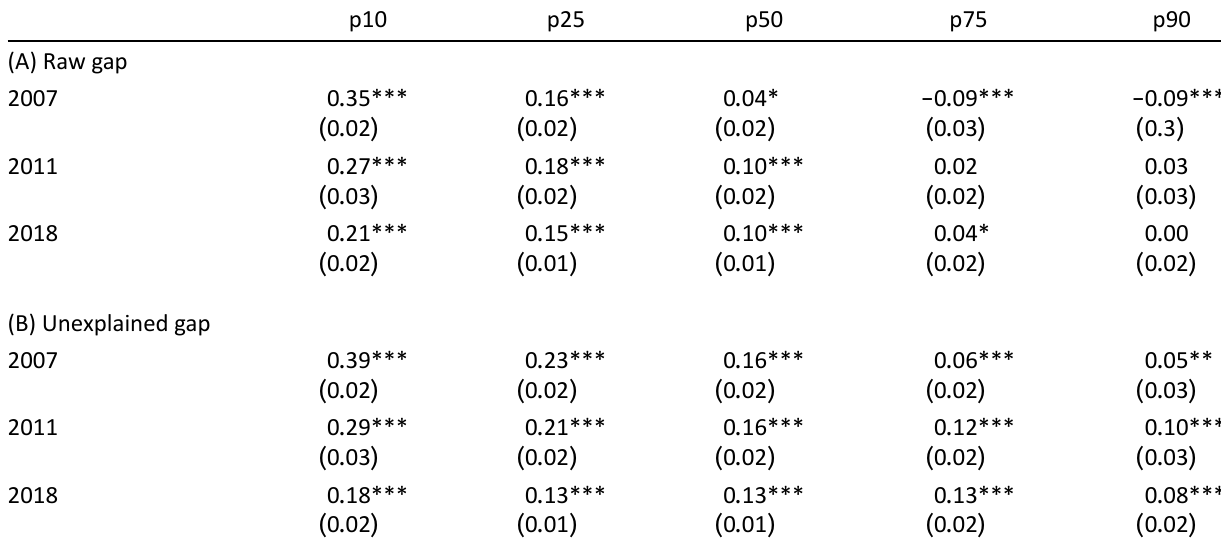
Table 5. Machado‐Mata quantile